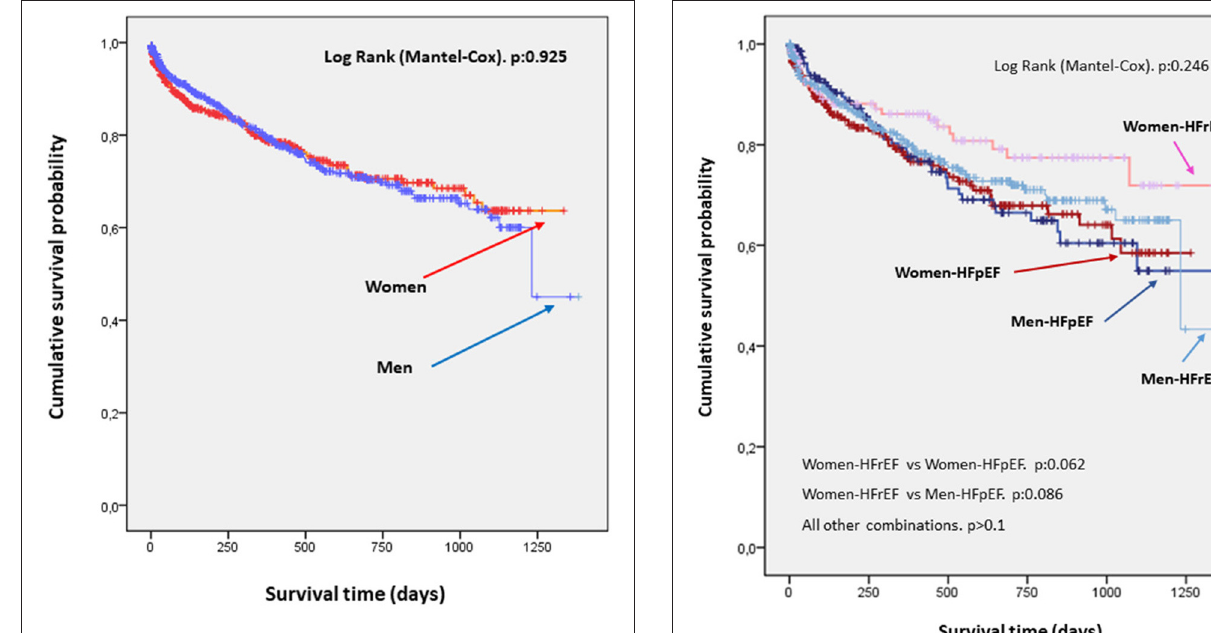
FIGURE 2 | Survival curves by sex. No significant differences were found in probability of survival in patients admitted for decompensated HF by sex.